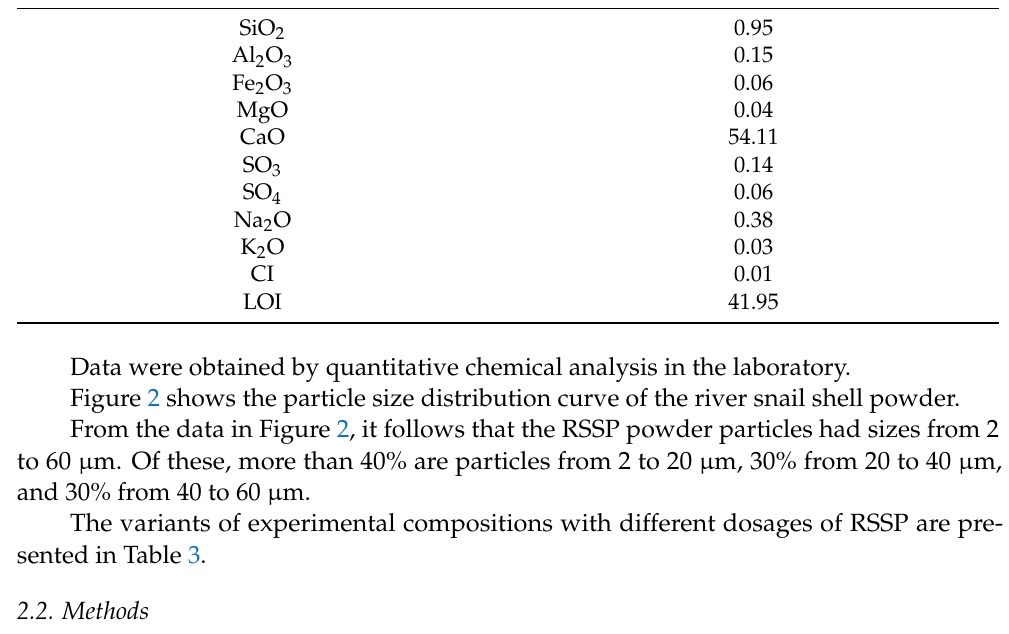
Figure 1. Appearance of snail shells: ( a ) after washing; ( b ) after grinding by pounding. The chemical composition of snail shells is presented in Table 2. Table 2. Chemical composition of RSSP.